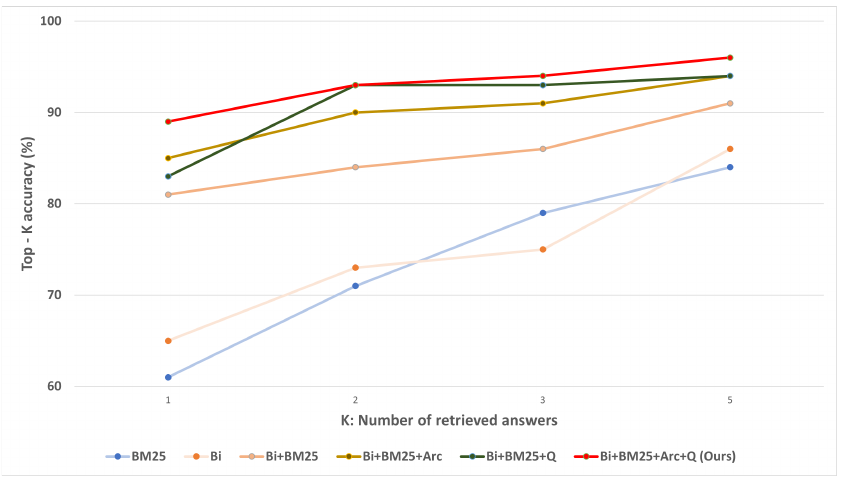
Figure 1. Top-K accuracy with different models used in sparse embedding retriever, dense embedding retriever, and score function. The results are measured on the paraphrased new question–response pairs. Our proposed hybrid retriever FAQ system with score function outperforms other models. Bi, Arc, and Q indicate bi-encoder, arctangent, and Q-blending,